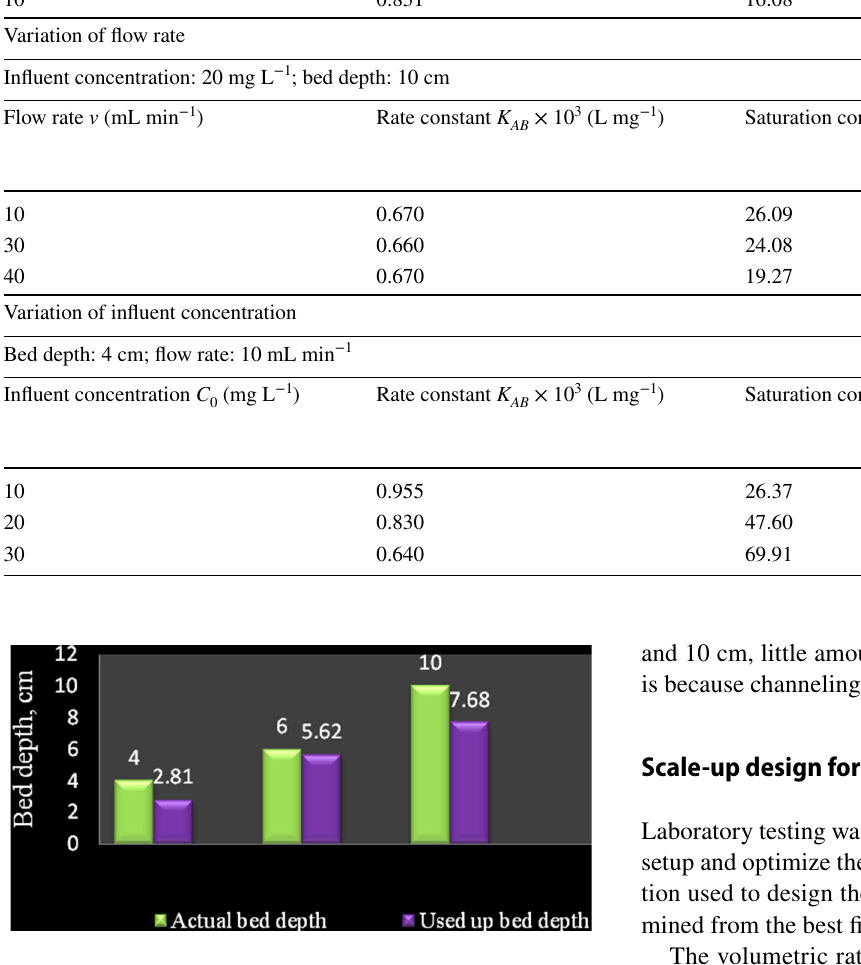
Fig. 7 Mass transfer